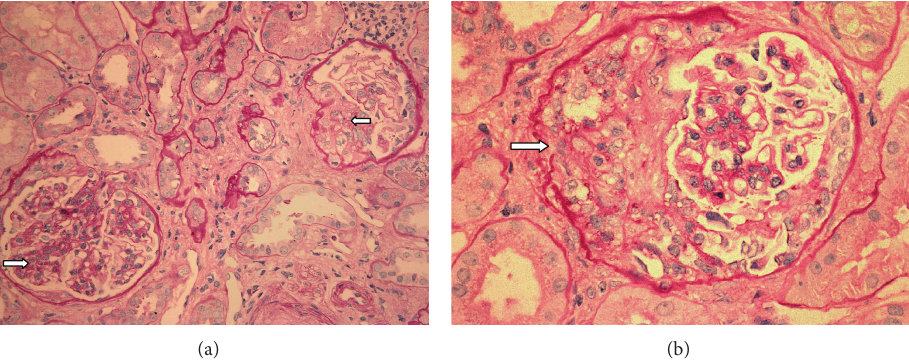
Figure 1: (a) The section shows glomeruli with moderate mesangial hypercellularity and a fibrocellular crescent. There is also mild tubular atrophy with tubular basement membrane thickening (PAS stain × 20). (b) Higher power shows the fibrocellular crescent with focal rupture of Bowman capsule (PAS stain × 40).